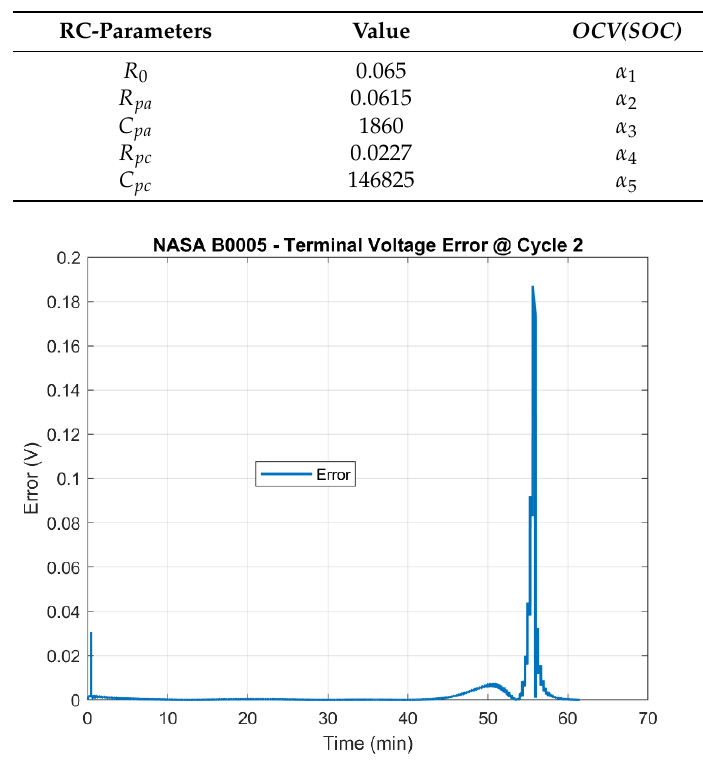
Figure 4. LS Model Error Squared: Terminal Voltage.